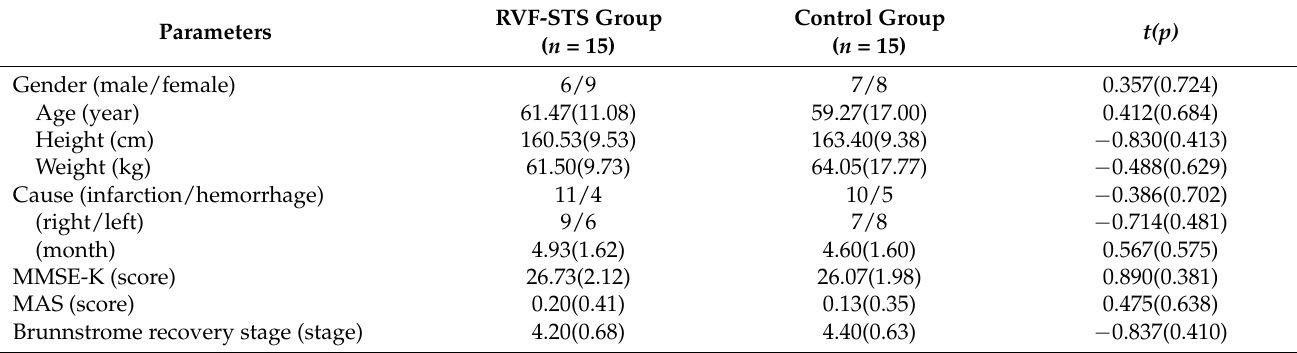
Table 2. General characteristics of subjects ( N =